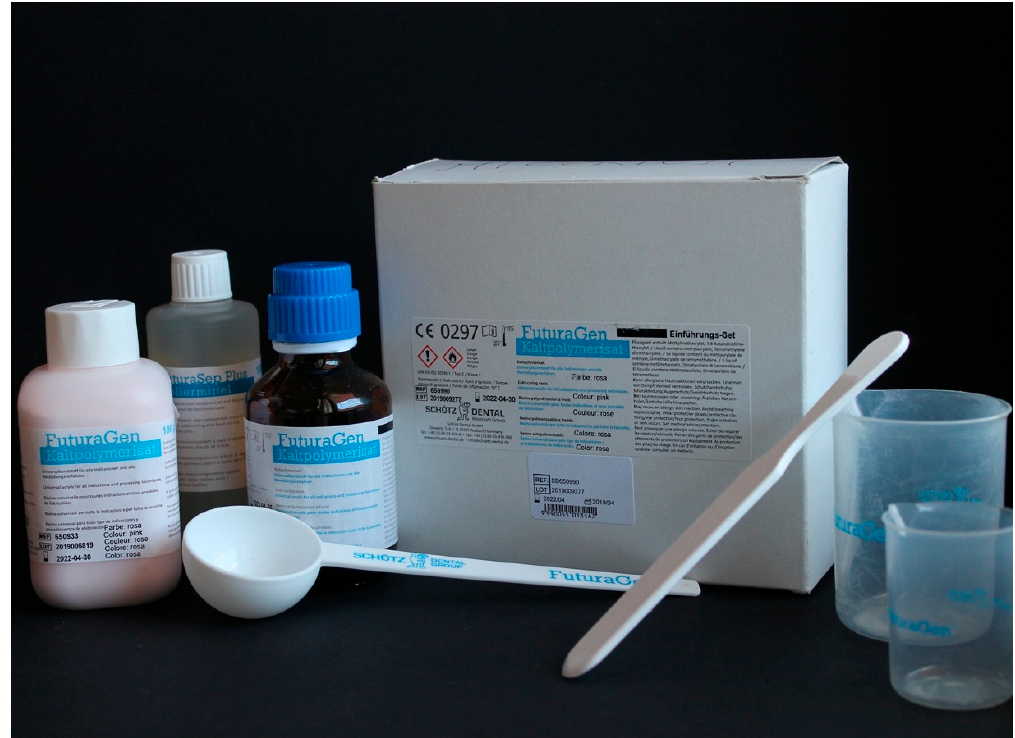
Figure 1. Sample of dental pink resin kit, containing (from left to right) resin powder, insulating liquid, resin liquid, a measuring spoon, a spatula, liquid and powder